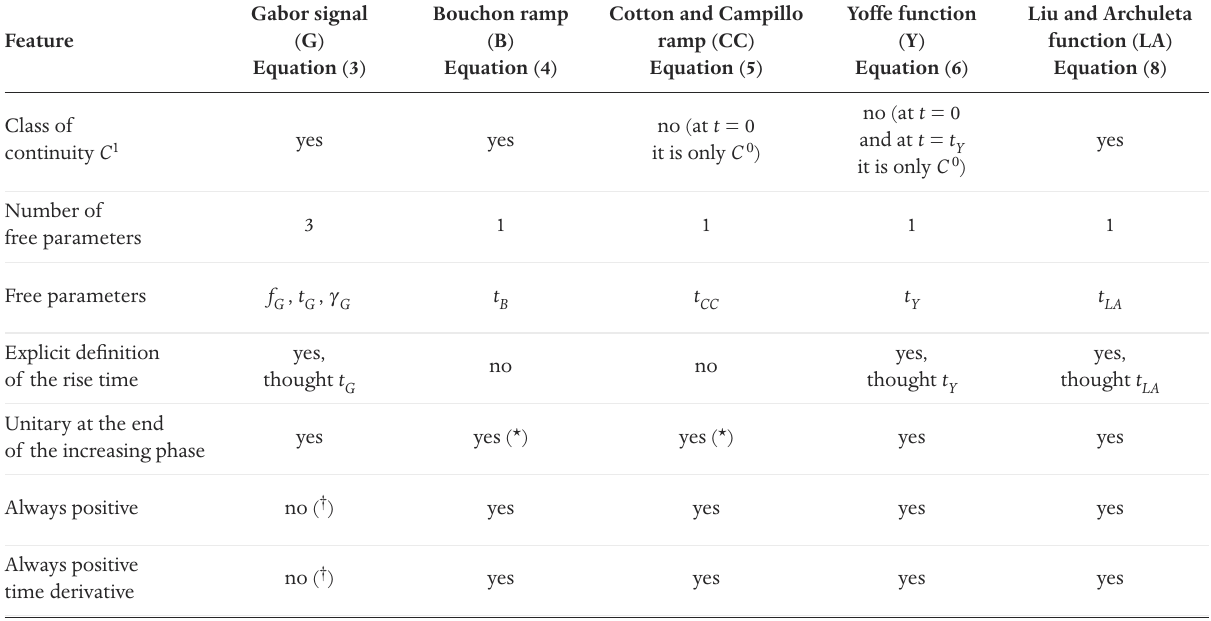
Table 1. Synoptic comparison of the most important features of the considered time evolutions of slip on the fault ( 〈 u ( t ) 〉 ) of the point- source approximation. (*) In asymptotic sense. ( † ) The function is not necessarily positive, depending on the adopted parameters. Just for an example, with f = 0.225 Hz, t = 1.5 s and c = 1.5 s we have negative slip and slip velocity at t = G G G